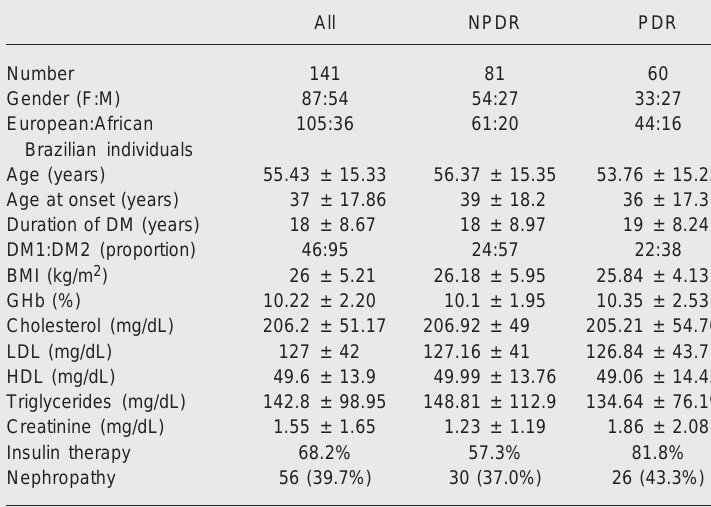
Table 1. Main clinical and laboratory data of diabetic patients.